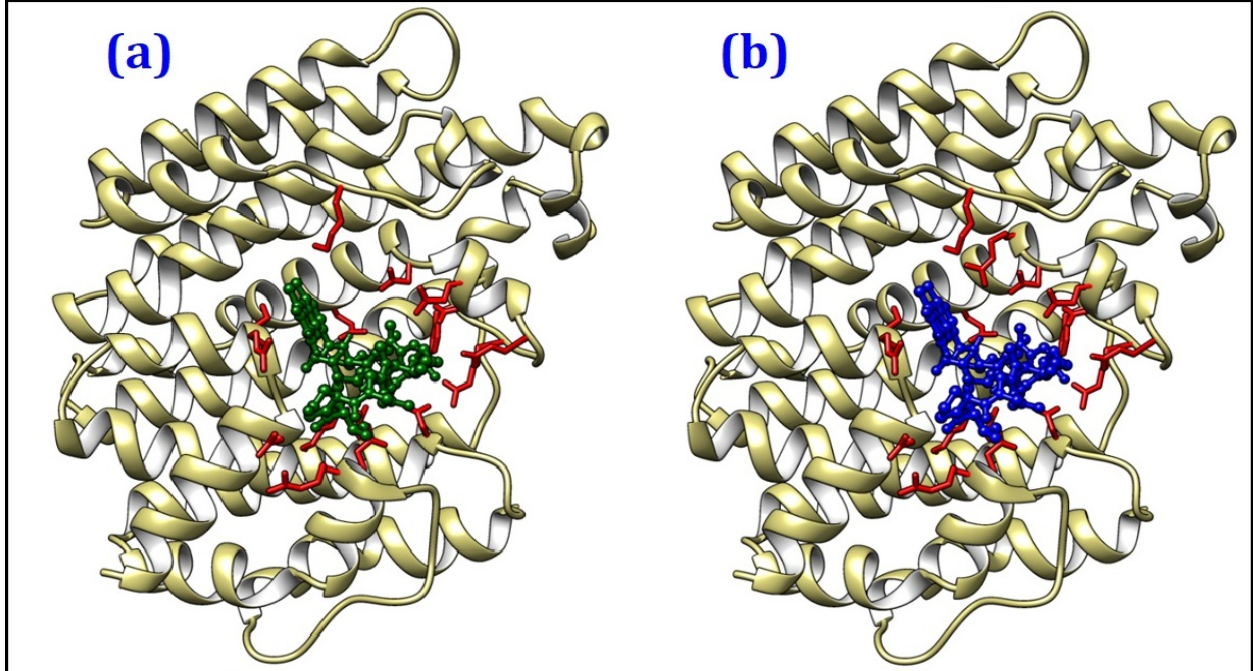
Figure 7. 3D interaction analyses of squalene synthase complexed with ( a ) actinomycin X 2 , and ( b ) actinomycin D as generated by the molecular docking exercises.